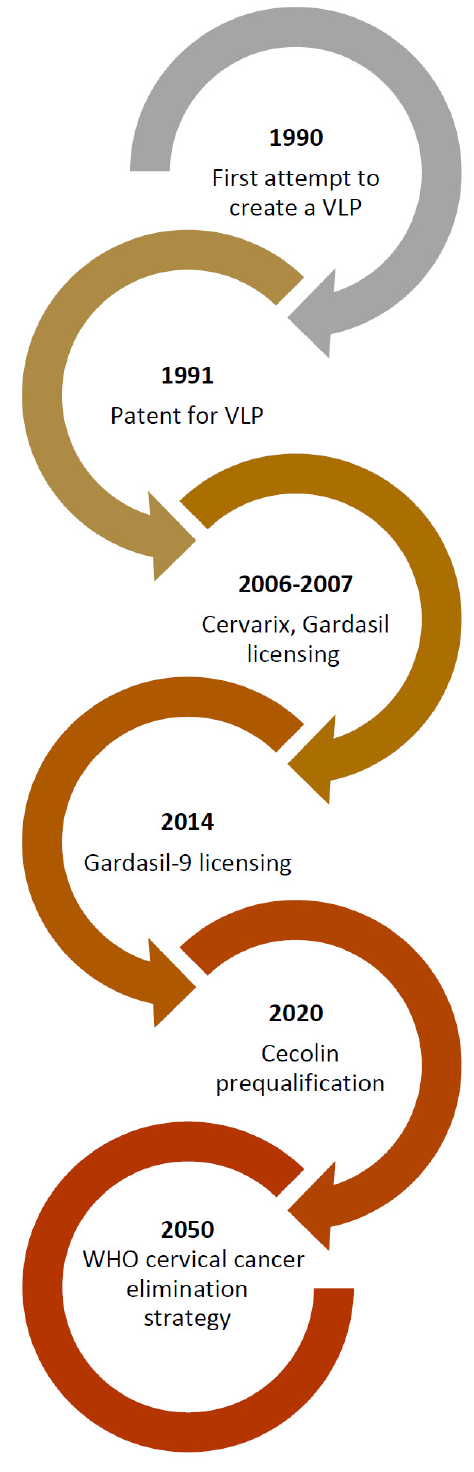
Figure 2. HPV vaccine development. Figure legend: VLP—virus-like particle; WHO—World Health Organization.